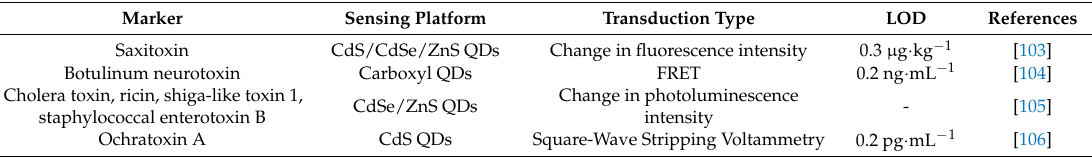
Table 8. QDs-based biosensors for toxins